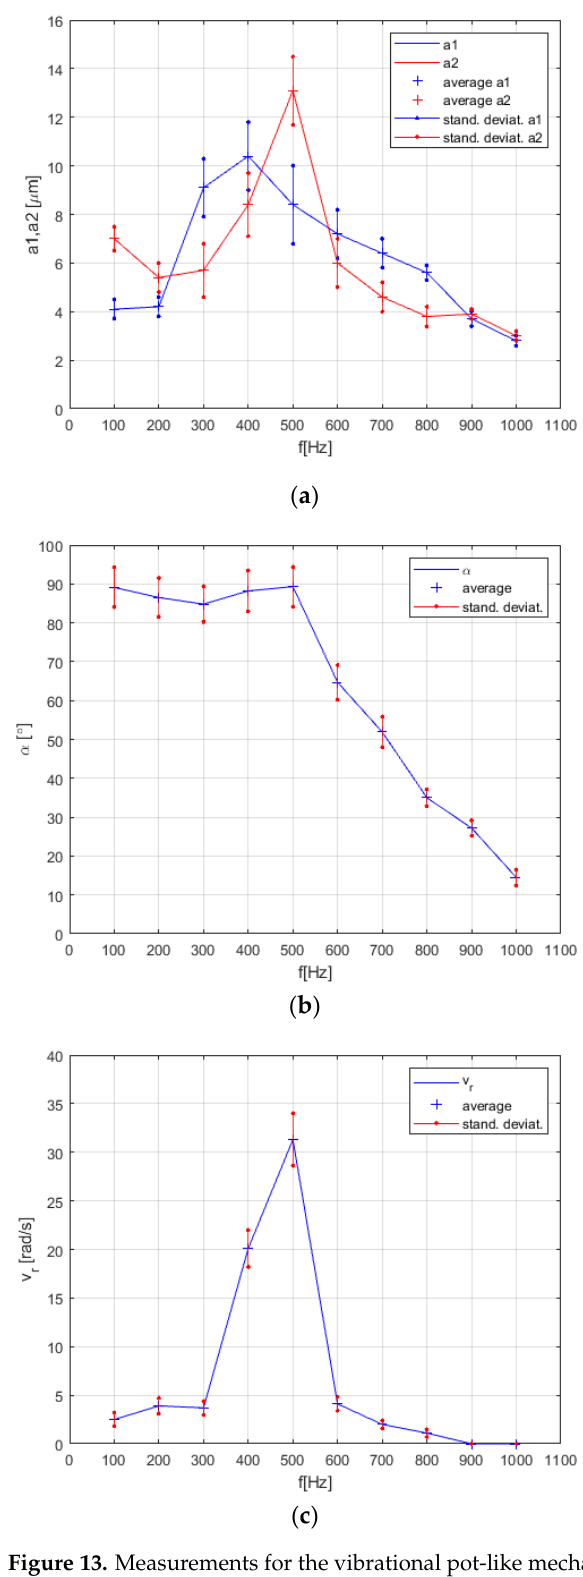
Figure 13. Measurements for the vibrational pot-like mechanism: ( a ) Vibration amplitudes a 1 and a 2 versus frequency f . ( b ) Phase shift α versus frequency f . ( c ) Rotational velocity v r versus frequency f .